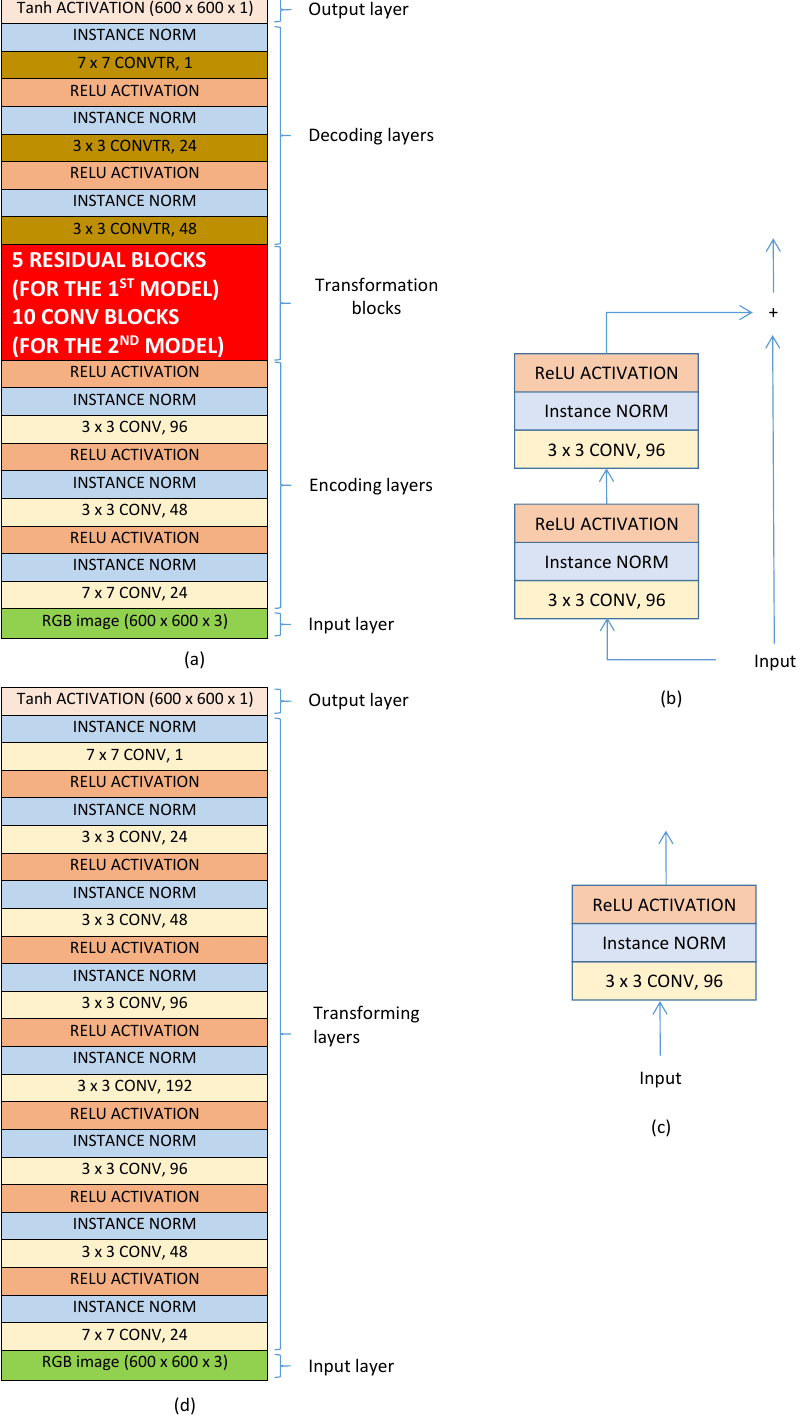
Figure 9. Structure of the three deep models: ( a ) structure of the two first models containing three main components: encoding component, transformation component and decoding component. ( b ) structure of a residual block. ( c ) structure of a convolutional block. ( d ) structure of the third model with convolutional blocks